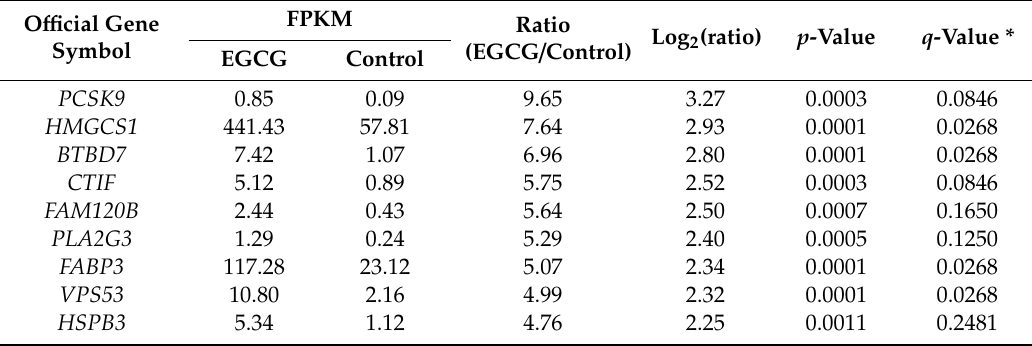
Table A1. Di ff erentially expressed genes in idiopathic pulmonary fibrosis (IPF) fibroblasts treated with epigallocatechin gallate (EGCG) versus water